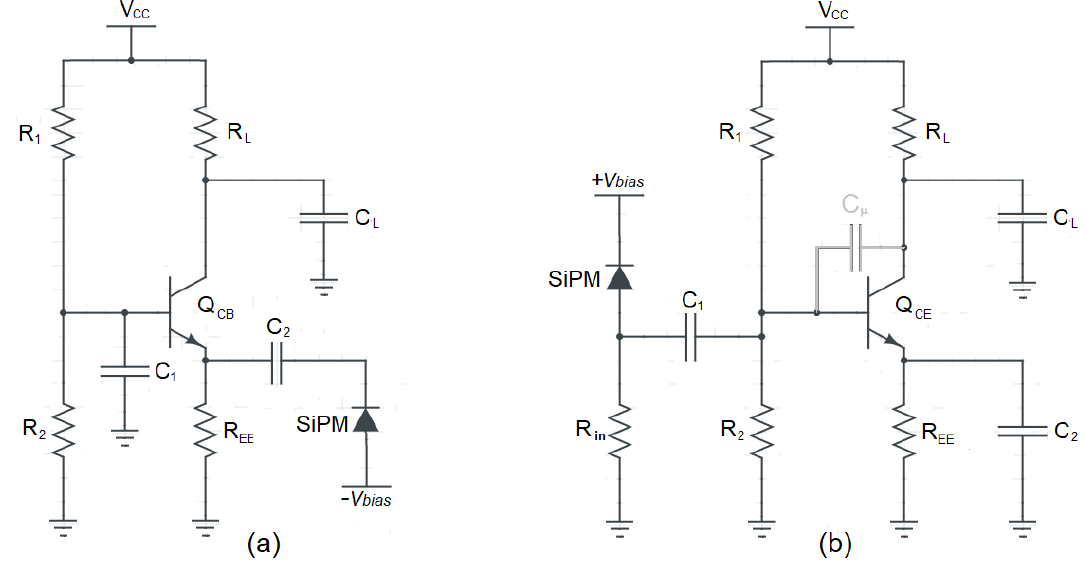
Figure 11. Two readout approaches: ( a ) a BJT in the common base configuration; ( b ) the same BJT in the common emitter configuration.